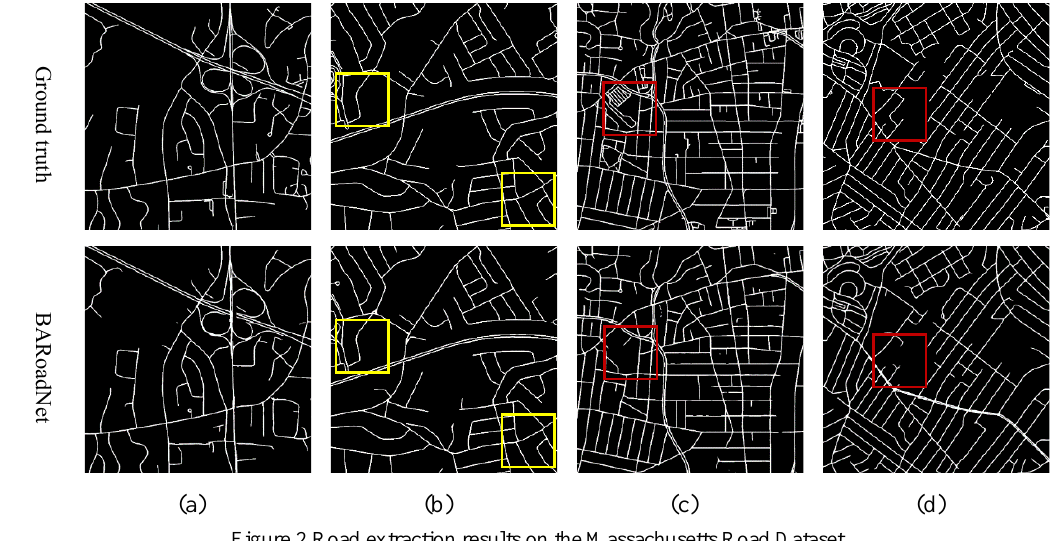
Figure 2 Road extraction results on the Massachusetts Road Dataset